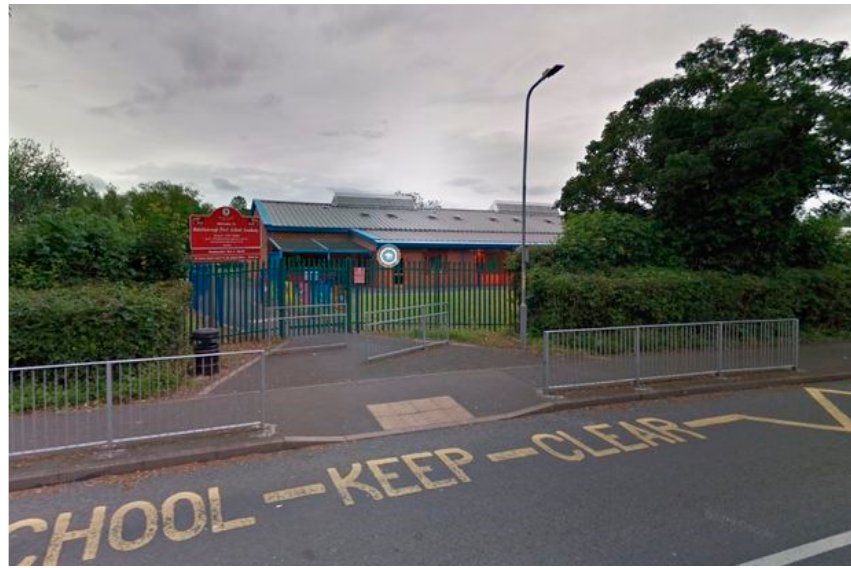
Figure A3. Entrance to the primary school.